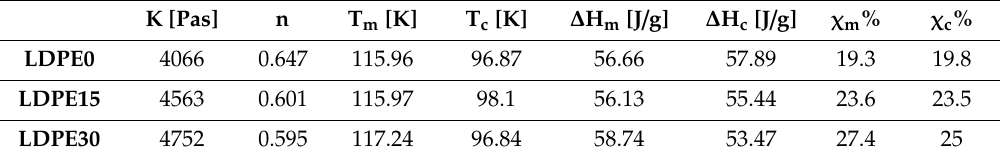
Table 5. Power law coe ffi cients (Equations (1) and (7)), melt enthalpy, crystallization enthalpy, and crystallinity of the neat LDPE and the composites.